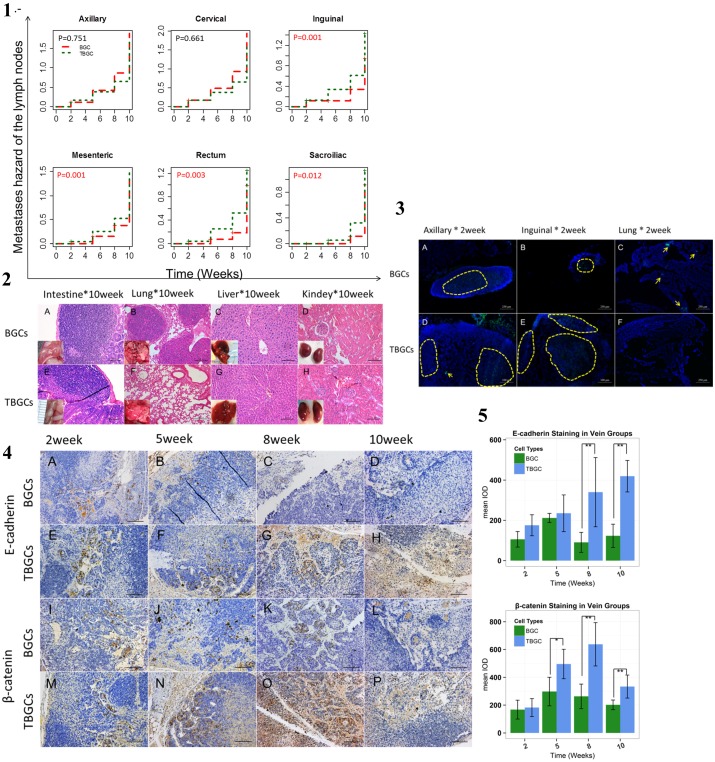
TBGCs exhibit in vivo lymph node propensity in the vein injection group.

Figure 4

.1. Cumulative risk of lymph nodes metastasis in different groups that received tail vein injections.
Figure 4

.2. HE staining (at 10 weeks) of organs in the group that received vein injections. Positivity was observed in the intestines of both groups and in the lungs of the BGC groups. No evident liver or kidney metastases were found.
Figure 4

.3. Fluorescent tracing of tumor cells at week 2 in the groups that received tail vein injections. Tumor cells were labeled with green fluorescence as indicated by the yellow arrowheads. The nucleus was stained with DAPI (blue). Magnification 100×.
Figure 4

.4. Immunohistochemical staining for E-cadherin and β-catenin in the lymph nodes of the groups that received tail vein injections at each time point. Magnification 200×.
Figure 4

.5. Bar plot of the relative expression levels of E-cadherin and β-catenin in the lymph nodes of the groups that received tail vein injections at each time point. **p<0.01; *p<0.05.